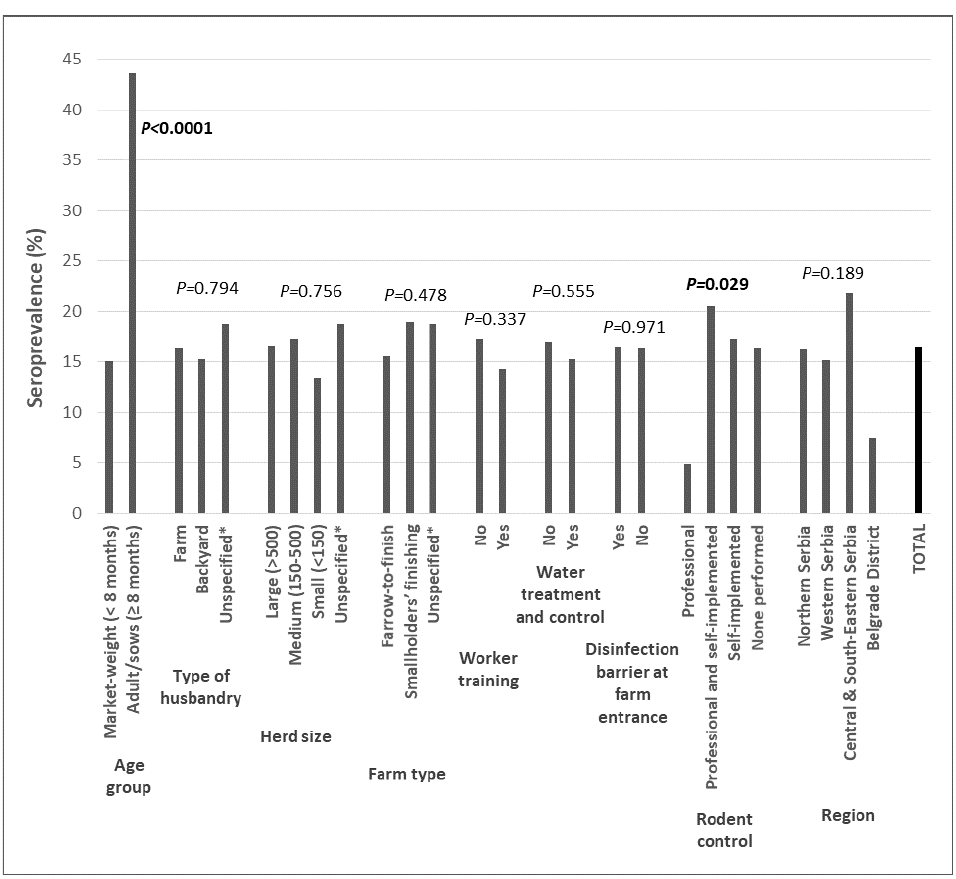
Figure 2. Toxoplasma gondii seroprevalence in all sampled pigs (N = 825) according to independent variable categories. p values for univariate logistic regression analysis (values ≤ 0.15 in bold). * pigs from pig traders’ operations.